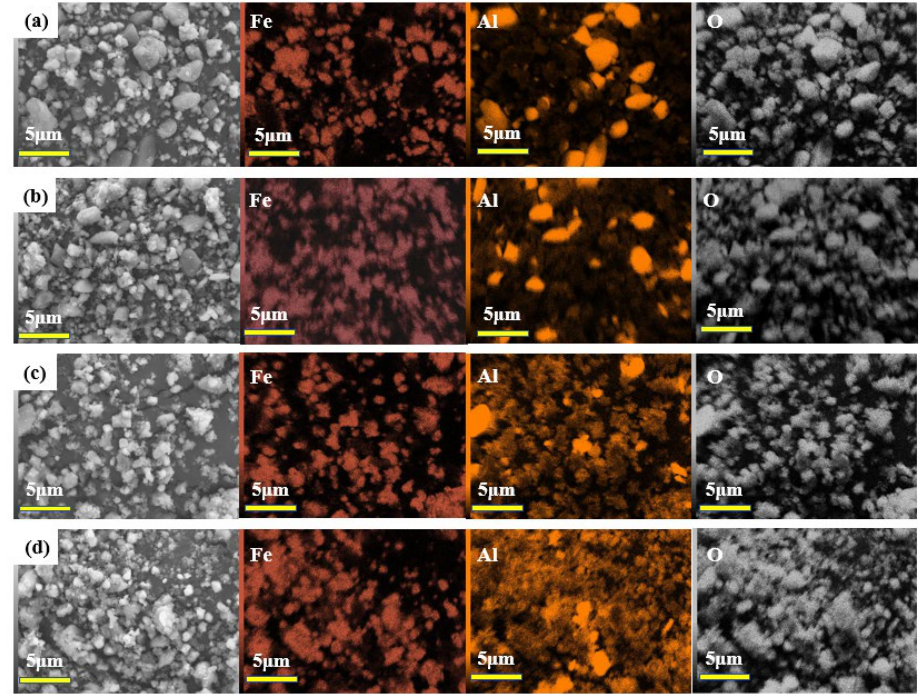
Figure 5. The SEM and energy spectrum surface scan images of samples with different electrolysis temperatures, 800 °C in ( a ), 850 °C in ( b ), 900 °C in ( c ) and 950 °C in ( d ).